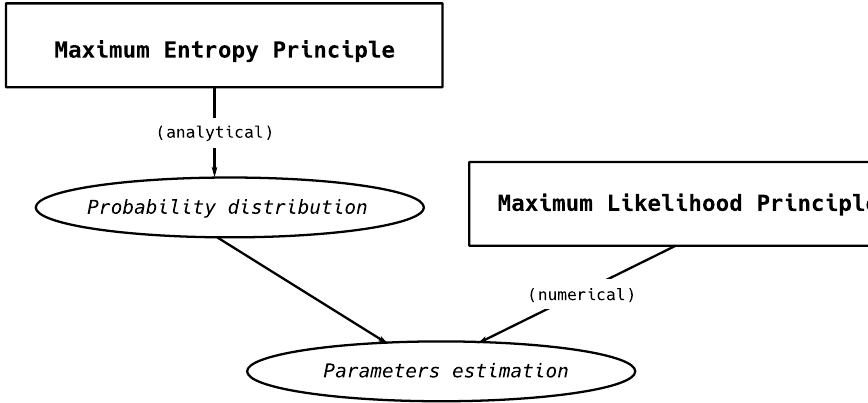
Figure 1. Graphical visualization of how the MEP and the MLP work: while the MEP allows the functional form of a probability distribution to be determined analytically, the MLP provides the recipe to numerically determine the parameters defining